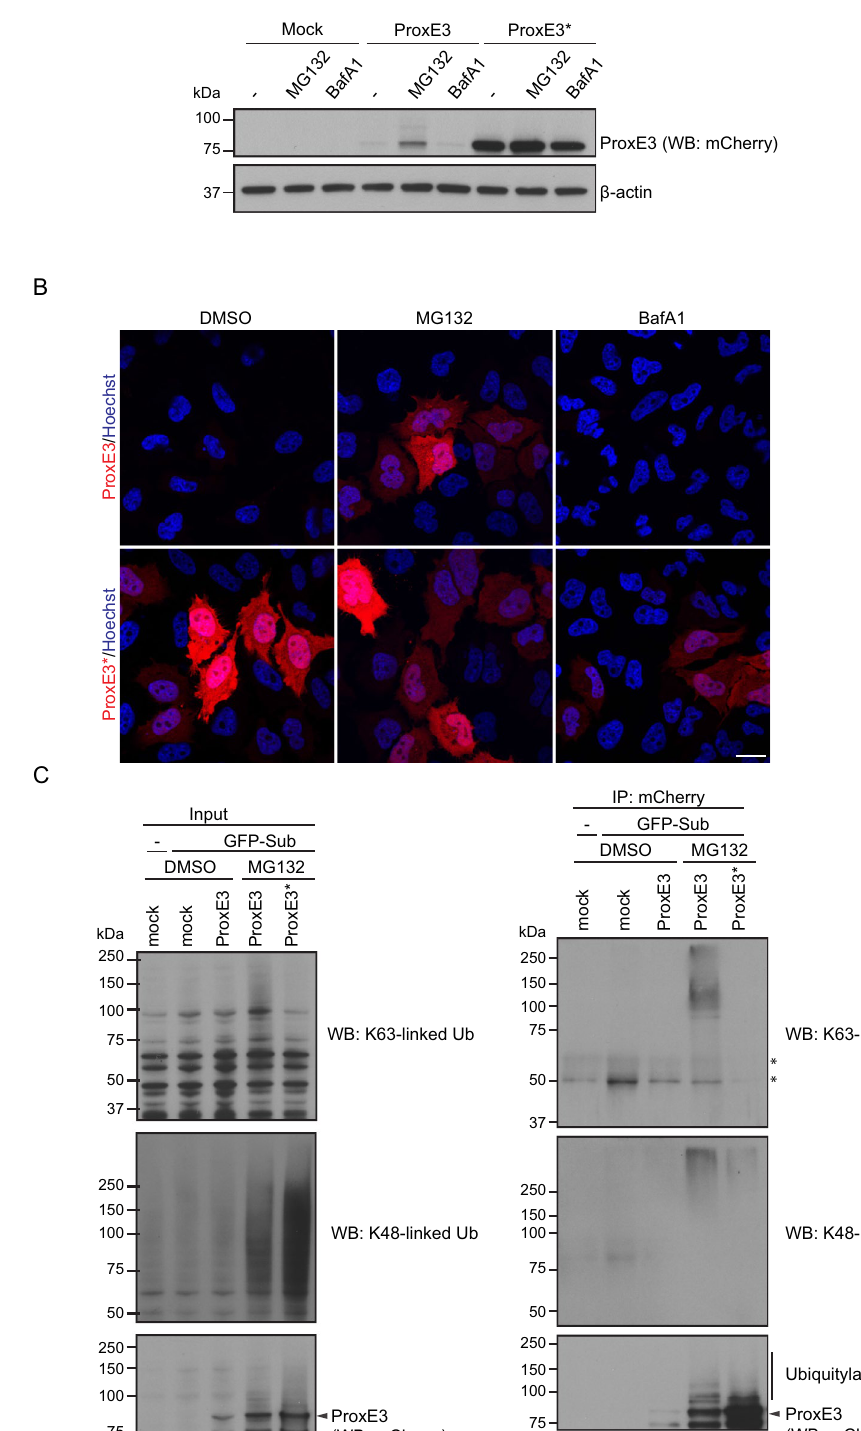
Figure 2. K48-linked ubiquitylation of ProxE3 in cells. ( A ) Western blot of HeLa cells transiently transfected with ProxE3, the catalytically inactive ProxE3* or mock transfected and treated for 5 h with 10 µM MG132, 100 nM Bafilomycin A1 (BafA1) or DMSO. ( B ) Representative confocal micrographs of HeLa cells transiently transfected with mCherry-ProxE3, -ProxE3* or mock transfected and treated for 8 h in the presence or absence of 10 µM MG132, 100 nM Bafilomycin A1 (BafA1) or DMSO. Hoechst counter staining is represented in blue. Scale bar: 20 µm. ( C ) Denaturing immunoprecipitation of mCherry-fusions in parental HeLa cells (−) or HeLa cells stably expressing GFP-Sub (GFP-Sub) and transfected with mCherry-tagged ProxE3, the catalytically inactive ProxE3* or mock transfected and treated for 12 h in the presence or absence of 10 µM MG132 (+ MG132 and − MG132 respectively). Arrows are pointing towards the unmodified protein of interest (either GFP-Sub or ProxE3), asterisks are indicating aspecific